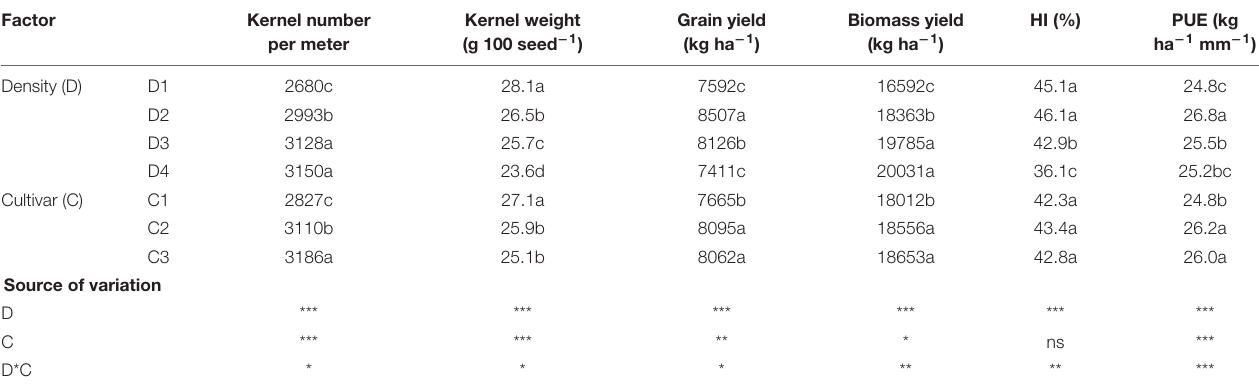
TABLE 1 | Maize grain yield and its components in different treatments.